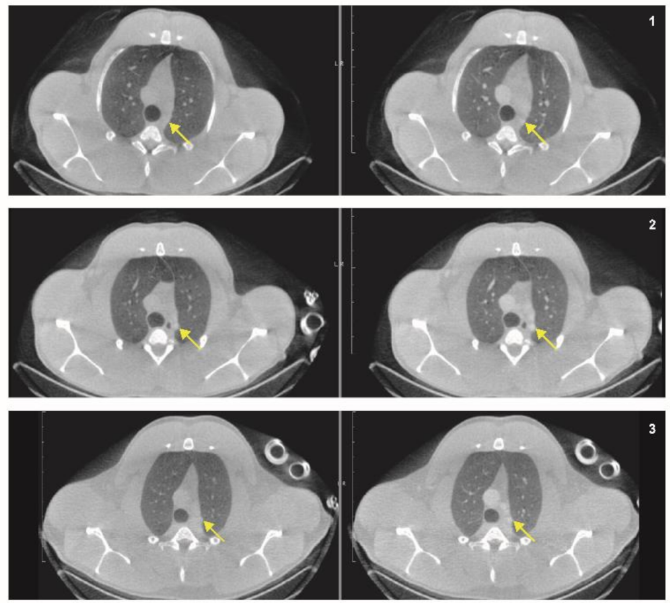
Figure 5. A representative pre-contrast (left) and post-contrast (right) transversal CT-slice are dis- played of three different contrast regimes. For all three the contrast is injected intravenously (IV) in a timeframe of 10 s followed by IV flushing with 0.9% NaCl for 20 s. 1. IV flush with 40 mL, start scan 120 s post injection, 2. IV flush with 40 mL, start scan 70 s post injection, 3. IV flush with 10 mL, start scan 30–40 s post injection. The arrows are pointing towards the increased visualization of the vessels with the different contrast application regimes. Similar window-level settings are applied to all